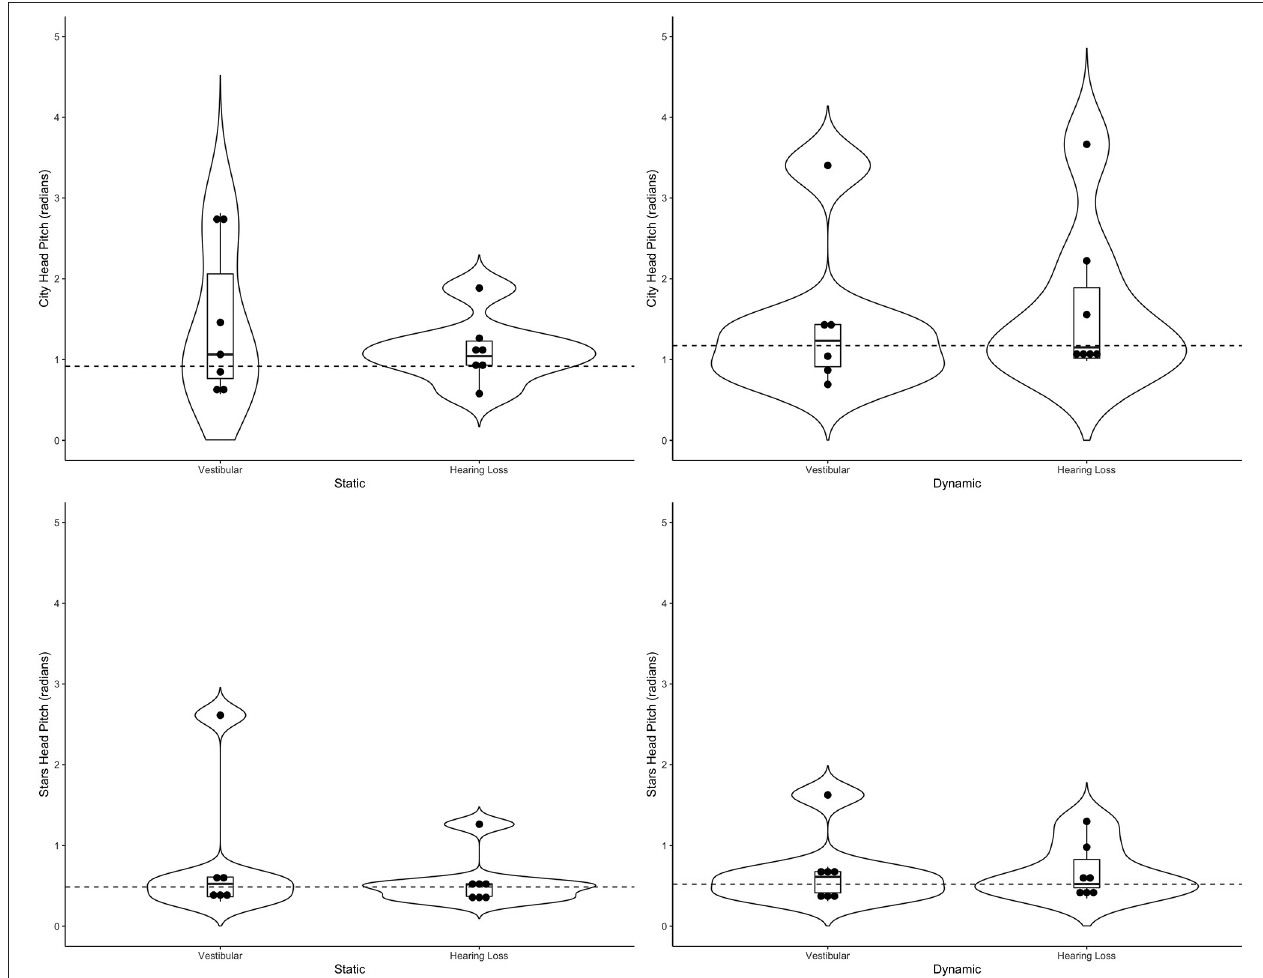
FIGURE 6 | Violin plots representing the distribution head pitch (radians) of both clinical groups around the mean of the control group (represented by the dashed line) for the city scene (top) and stars scene (bottom) Left-hand side represents the static scenes and right-hand side represents the dynamic